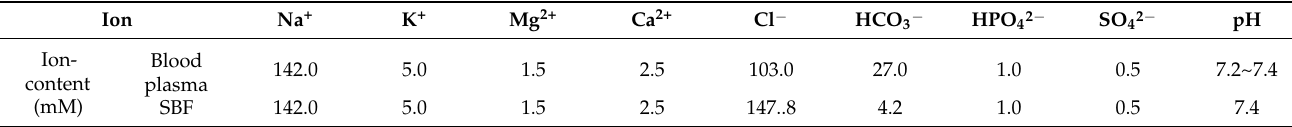
Table 1. Ion-content in human blood plasma and